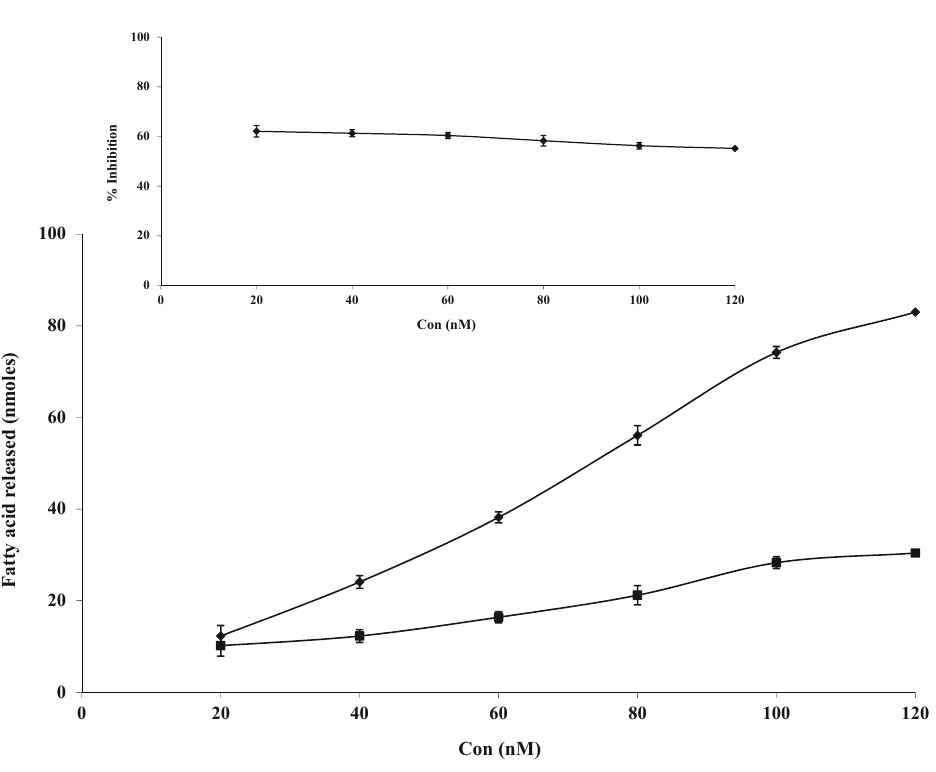
Figure 2 - Dose dependent inhibition of indirect hemolytic activity of NN-XIa-PLA by aqueous stem bark 2 extract of M. indica . NN-XIa-PLA (4 μ g) in 100 μ l of phosphate-buffered Saline (PBS) was preincubated 2 with or without aqueous stem bark extract of M. indica at various concentrations (0-40 μ g/ml). The reaction was started by adding erythrocytes, egg yolk and PBS (1:1:8 v/v) incubated for 10 min at 37 °C. The released hemoglobin in the supernatant was measured by taking absorbance at 540 nm. The results show ± S.E.M. for